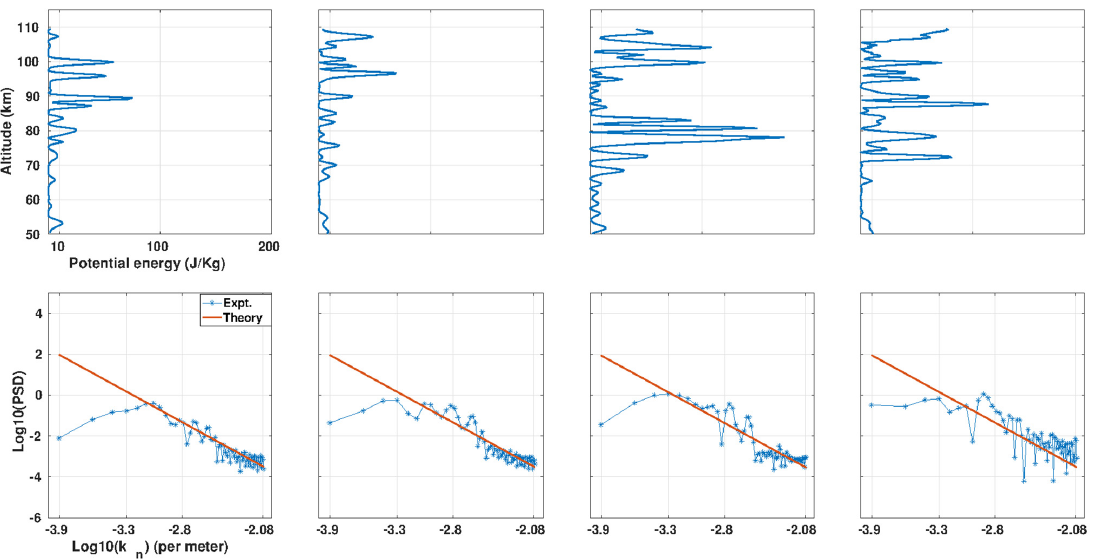
Figure 9. Potential energy of the gravity wave ( top panels ) versus altitude and logarithm of theoretical ( red line ) and experimental ( lines with asterisks ) power spectral density normalized temperature perturbation versus the logarithm of the vertical wave number of atmospheric gravity wave ( bottom panels ) on 14 October 2011.